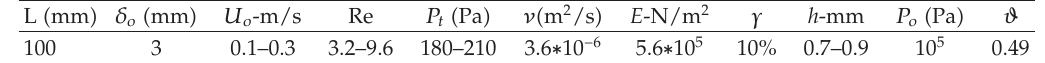
Table 1: Input data utilized in this study.